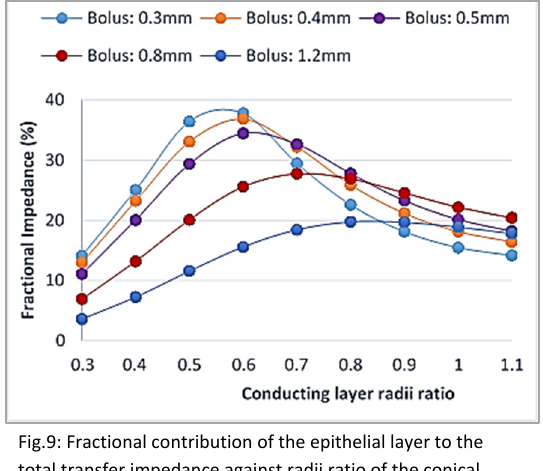
Fig.9: Fractional contribution of the epithelial layer to the total transfer impedance against radii ratio of the conical conducting layer for different conducting layer height. Edge to edge electrode separation 2mm.